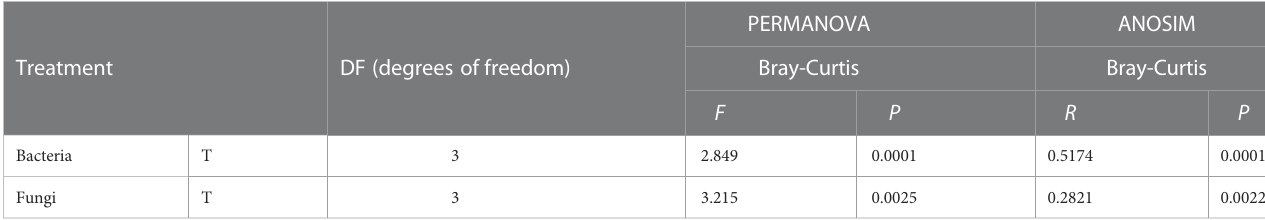
TABLE 2 The statistical test of similarity (ANOSIM) and permutational multivariate two-way analysis of variance (PERMANOVA) to analysis the differences of bacterial and fungal community composition by amplicon sequencing.